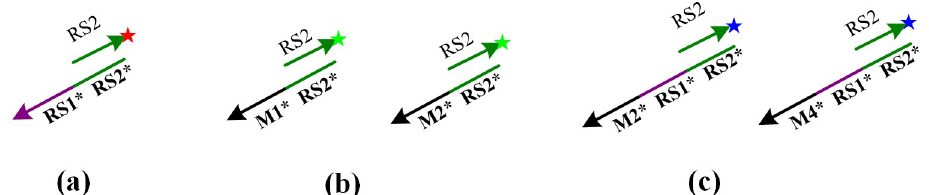
Fig 4. Three different fluorescent color detectors.